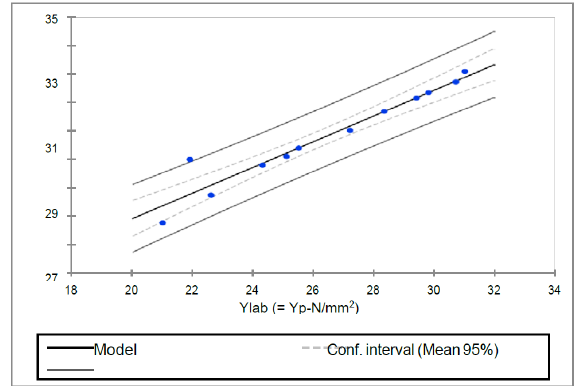
Figure 9: Regression of Y Model (N/mm 2 ) by Y Lab (= Yp-N/mm 2 ) (R 2 =0.931)